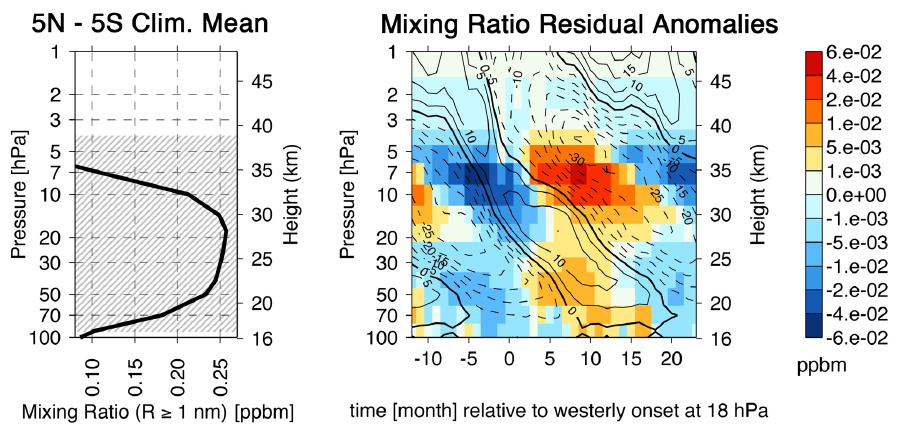
Figure 6. (a) Climatological mean profile of the modelled aerosol mass mixing ratio between 5 ◦ N and 5 ◦ S for the period 1996–2006. (b) Composite of QBO-induced residual anomalies in the modelled aerosol mass mixing ratio with respect to the time of onset of westerly zonal mean zonal wind at 18hPa. As in Fig. 2b, black contours denote the residual zonal wind. Dashed lines represent easterlies, contour interval is 5ms − 1 . Grey shades in (a) denote levels where the QBO signal exceeds the 95% significance level, according to the standard Student’s t